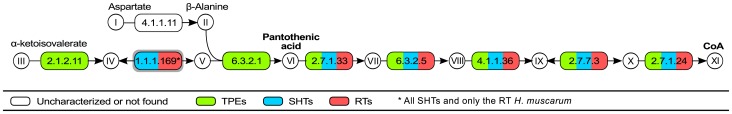
Biosynthesis of pantothenic acid and coenzyme A.Enzymes surrounded by a gray box were possibly acquired through horizontal transfer from Bacteria to trypanosomatids (see main text). Metabolites - I: Aspartate; II: β-Alanine; III: α-ketoisovalerate; IV: 2-Dehydropantoate; V: Pantoate; VI: Pantothenic acid; VII: D-4'-Phosphopantothenate; VIII: (R)-4'-Phosphopantothenoyl-L-cysteine; IX: Pantetheine 4'-phosphate; X: Dephosphocoenzyme A; XI: Coenzyme A. Enzymes -
4.1.1.11: aspartate 1-decarboxylase; 2.1.2.11: 3-methyl-2-oxobutanoate hydroxymethyltransferase; 1.1.1.169: ketopantoate reductase; 6.3.2.1: pantoate--beta-alanine ligase; 2.7.1.33: pantothenate kinase; 6.3.2.5: phosphopantothenate-cysteine ligase; 4.1.1.36: phosphopantothenoylcysteine decarboxylase; 2.7.7.3: pantetheine-phosphate adenylyltransferase; 2.7.1.24: dephospho-CoA kinase.